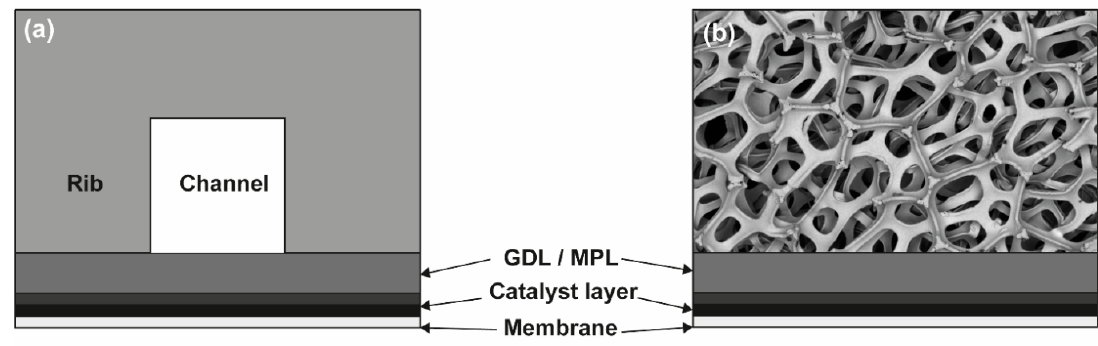
Figure 1. Cross section illustration of ( a ) conventional rib and channel flow-field and ( b ) porous metal foam flow-field.